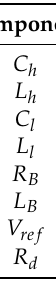
Table 8. Energy storage parameter